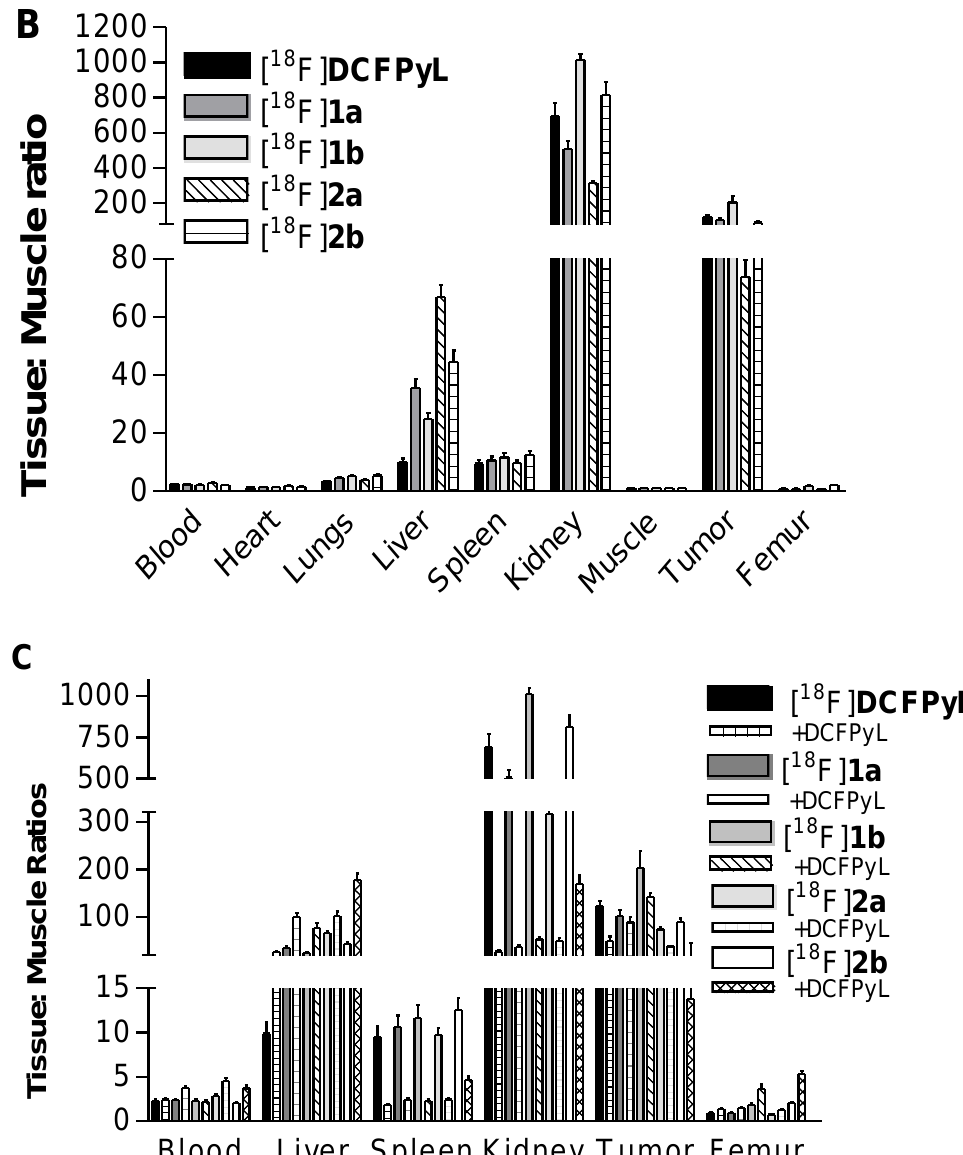
Figure 5. ( A , B ) Biodistribution [%ID/g (normalized to 20 g mouse); Tissue (%ID/g) to Muscle (%ID/g) ratios (T:M)] of [ 18 F]DCFPyL and analogues in PC3(+) xenografts at 60 min. Each bar in the graph represents the mean (%ID/g or T:M) ± SE ( n = 8–10 per group); ( C ) Tissue (%ID/g) to Muscle (%ID/g) ratios of [ 18 F]DCFPyL and analogues determined from PC3(+) xenograft biodistributions at 60 min injected with [ 18 F]DCFPyL only or coinjected with DCFPyL (1000 × ; ~10 to 80 nmol). Each bar in the graph represents the mean T:M ± SE ( n = 8–10 per group, except n = 5 for [ 18 F]1b + DCFPyL and [ 18 F]2a + DCFPyL